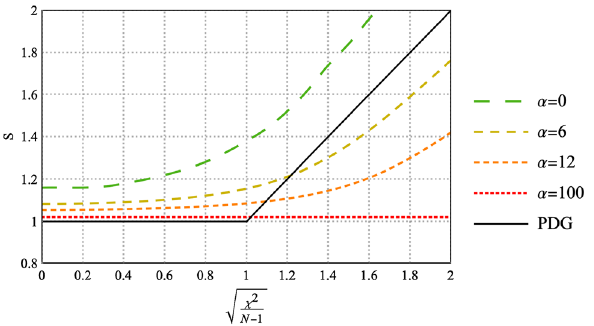
Fig. 4 Scale factor versus the square root of the reduced χ 2 for the case N = 10